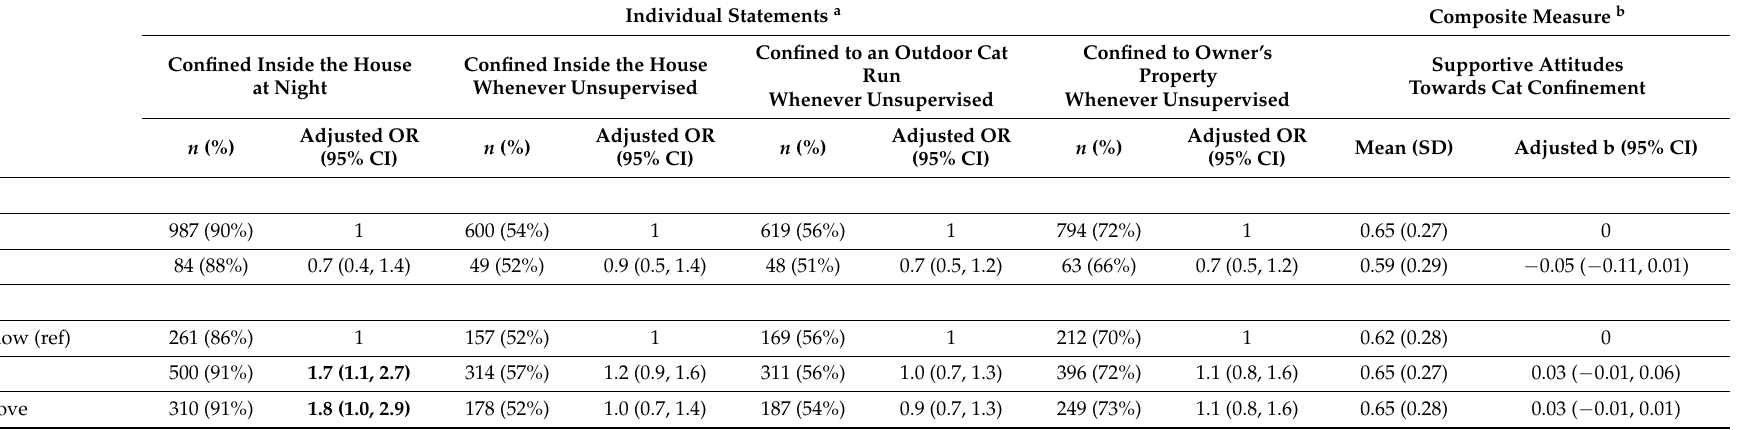
Table 4. Associations between demographic variables and agreement (agree/strongly agree) to statements about cat confinement as well as composite measure “supportive attitudes towards cat confinement” among cat owners ( n =